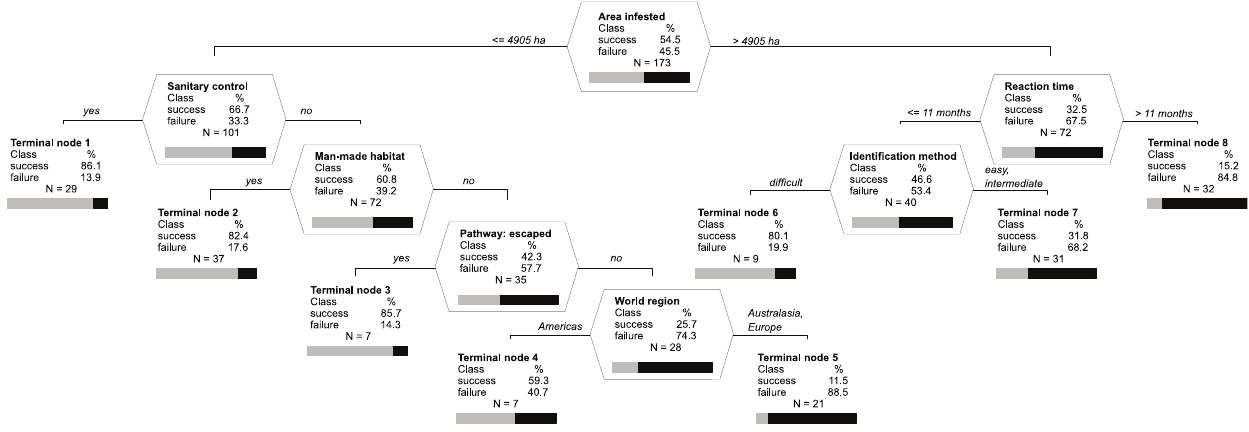
Figure 3. Optimal classification tree with event-specific factors placed at the top of the tree. Otherwise as in Fig. 1. Overall misclassification rate of the optimal tree is 18.0% with 15.3% misclassified success and 23.4% failure cases. Sensitivity and specificity are respectively 84.7 and 76.6% for learning, and 66.7 and 64.9% for cross-validated samples. Detail explanation of misclassification rates, sensitivity and specificity is in Fig.